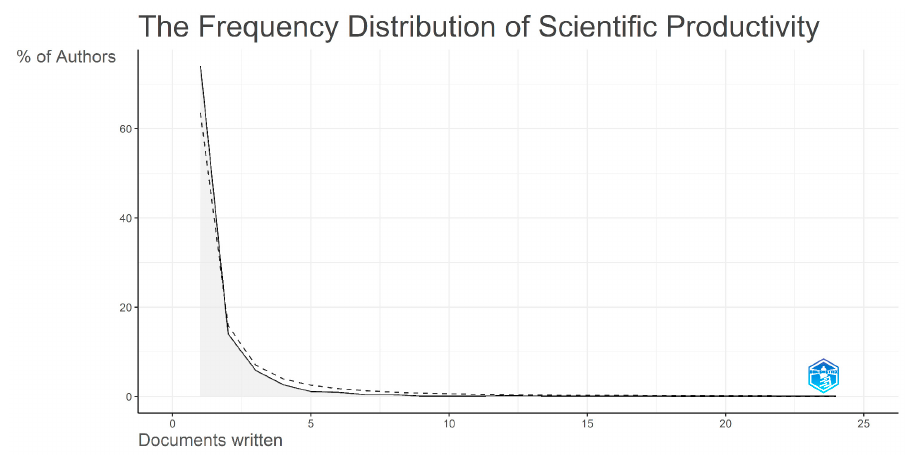
Figure 12. Authors’ productivity in CBD_NDT research according to Lotka’s law.